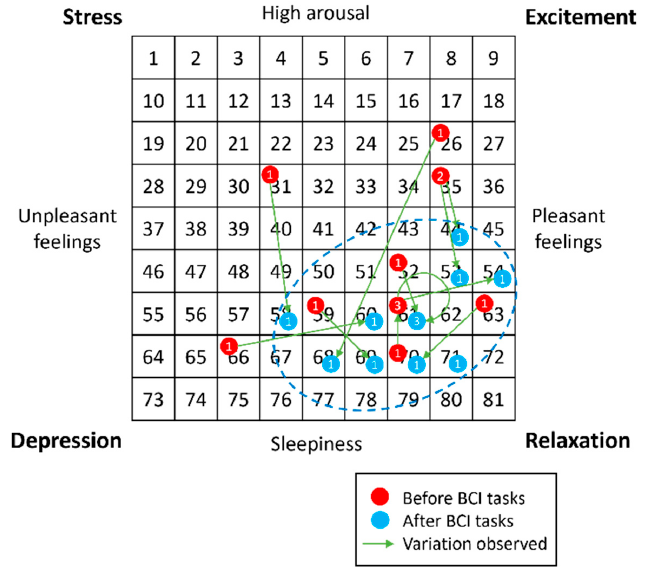
Figure 5. Results for each participant on the Affect Grid questionnaire, before and after the brain– computer interface (BCI) tasks. The number inside each circle refers to the number of participants who obtained that score. who obtained that